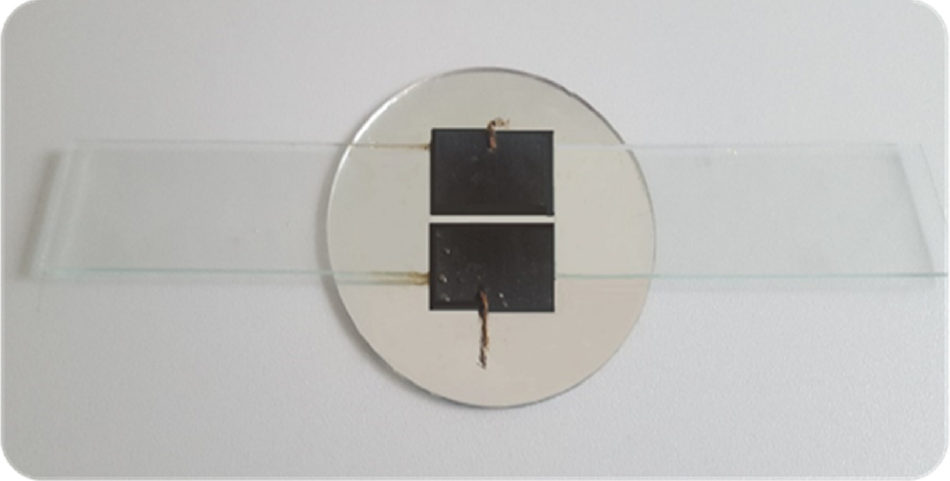
Figure 2. Glass vessel with electrodes for in situ observation of the ER effect mechanism.